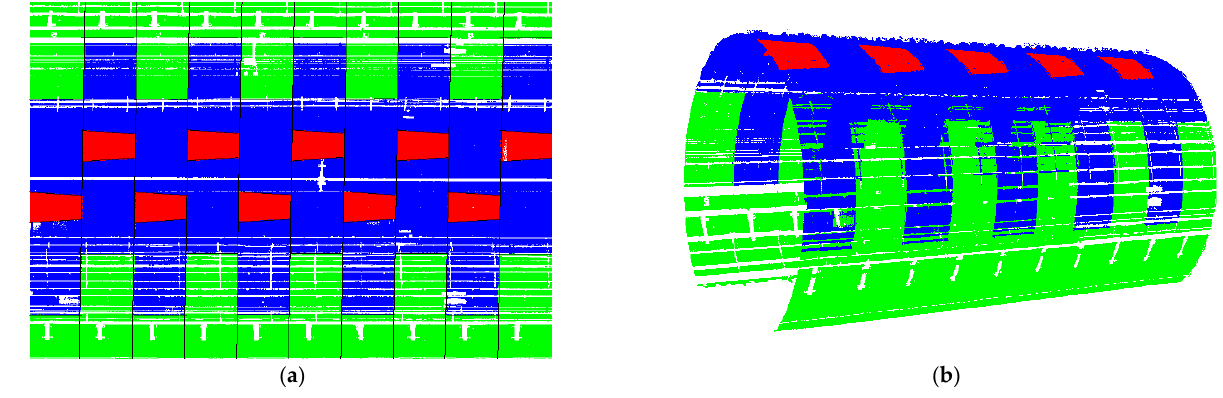
Figure 11. Positioning effect of a shield tunnel in the ( a ) expanded state and ( b ) original state.